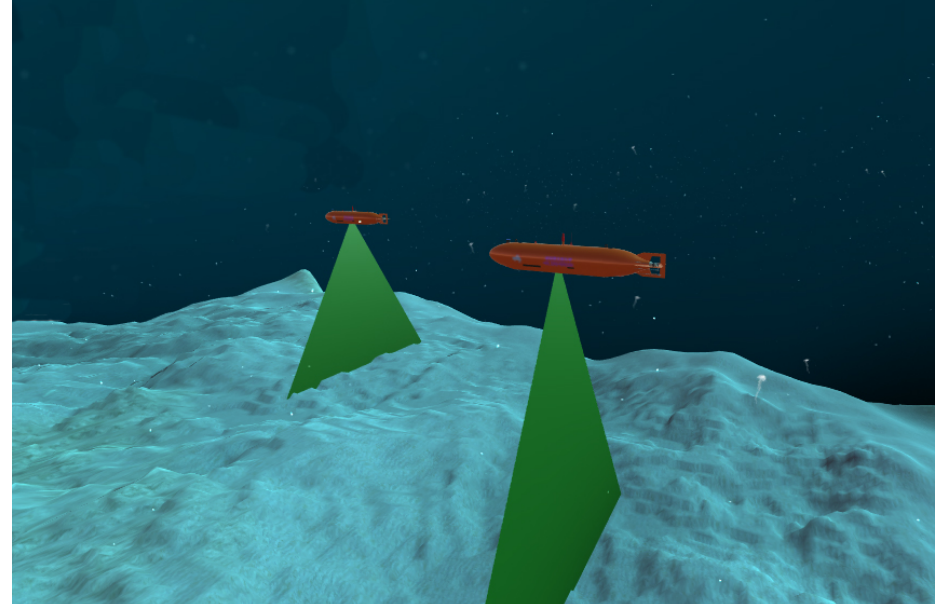
Figure 1. Underwater multi-autonomous underwater vehicles (MAUVs) detection